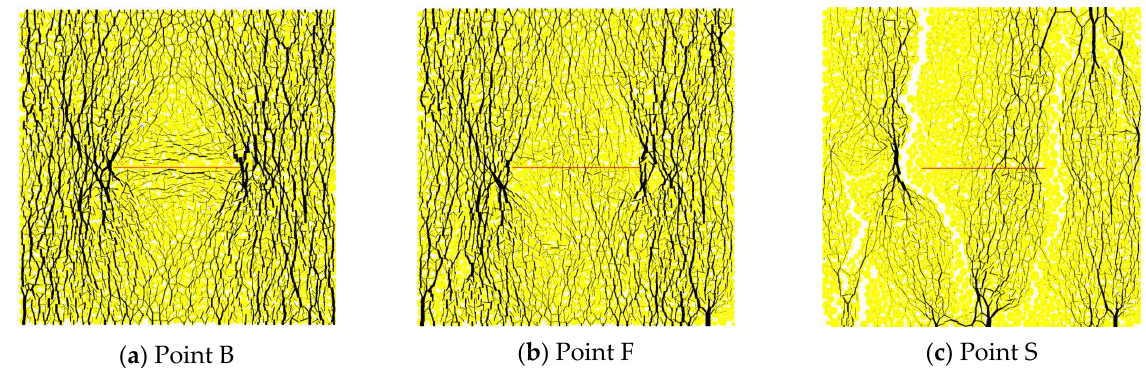
Figure 10 . Evolution of force chain distribution with axial strain increases ( 𝛽 =0°)